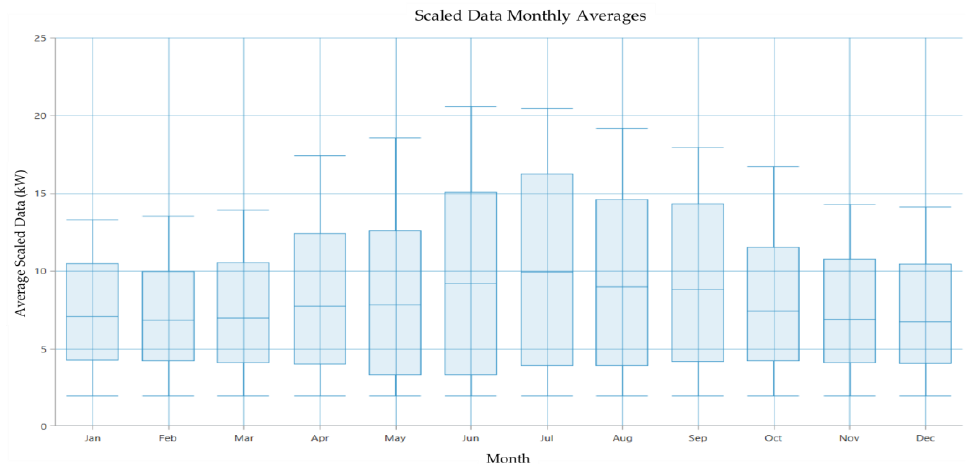
Figure 6. Monthly Load Profile in Dubai.